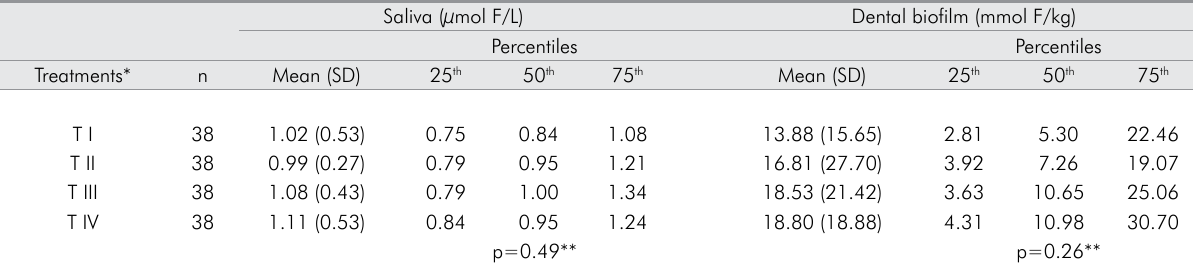
Table 1. Fluoride concentrations in saliva and in dental biofilm after different treatments Saliva (µmol